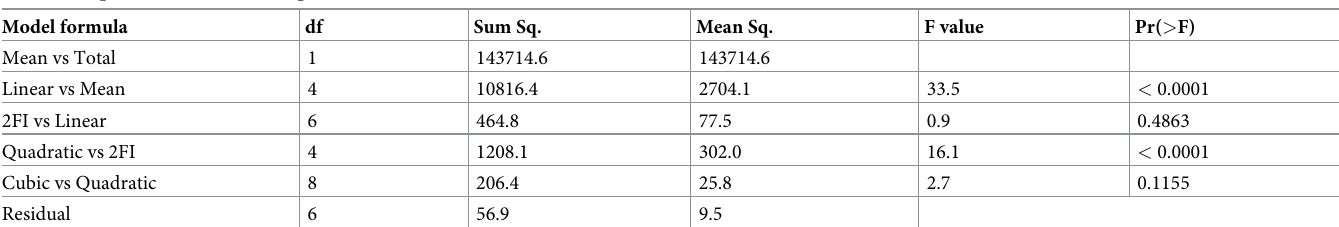
Table 4. Sequential model sum of squares.